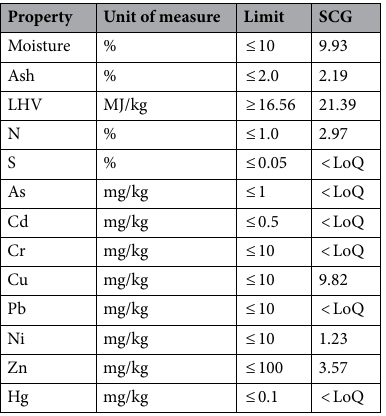
Table 12. Property of SCG pellet and limits of